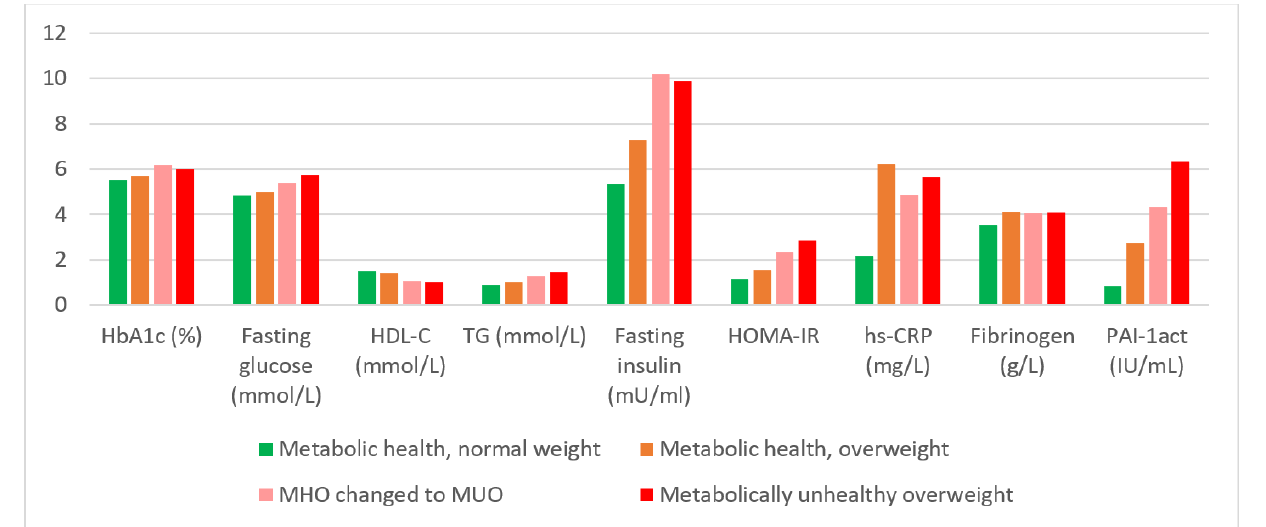
Figure 2. Metabolic profiles of the participants at follow-up according in the four main groups of BMI category and metabolic health.